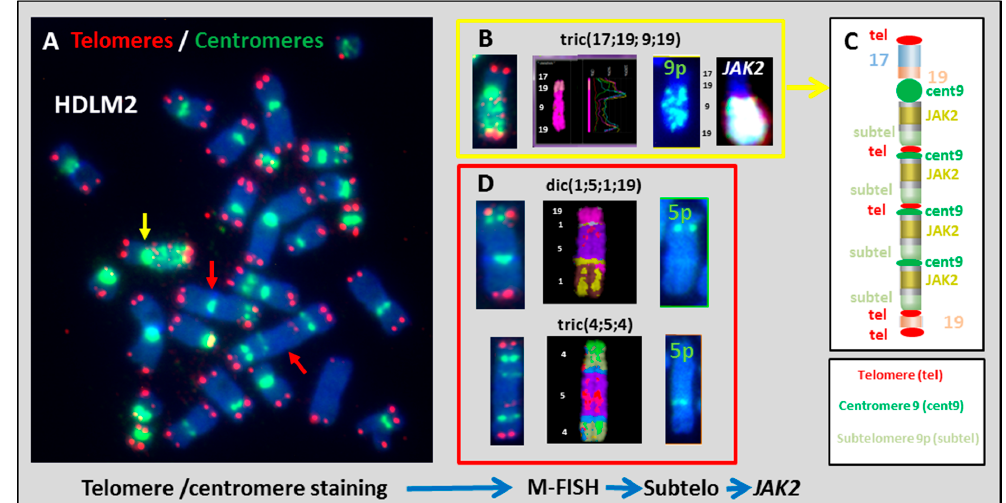
Figure 3. Dicentric chromosome formation in HDLM2. ( A ) Telomere and centromere staining show the presence of several clonal dicentric chromosomes (100× magnification). ( B ) tric(17;19;9;19) contained several centromeric, telomeric, and subtelomeric sequences of 9p. JAK2- specific FISH revealed amplification of this gene. ( C ) This approach makes it possible to schematize this chromosome resulting from B/F/B cycles. ( D ) Two other clonal dicentric chromosomes were analyzed using the same approach: dic(1;5;1;19) and tric(4;5;4) and the presence of subtelomeric sequences of 5p was also confirmed in these two dicentric configurations with complex chromosomal rearrangements.